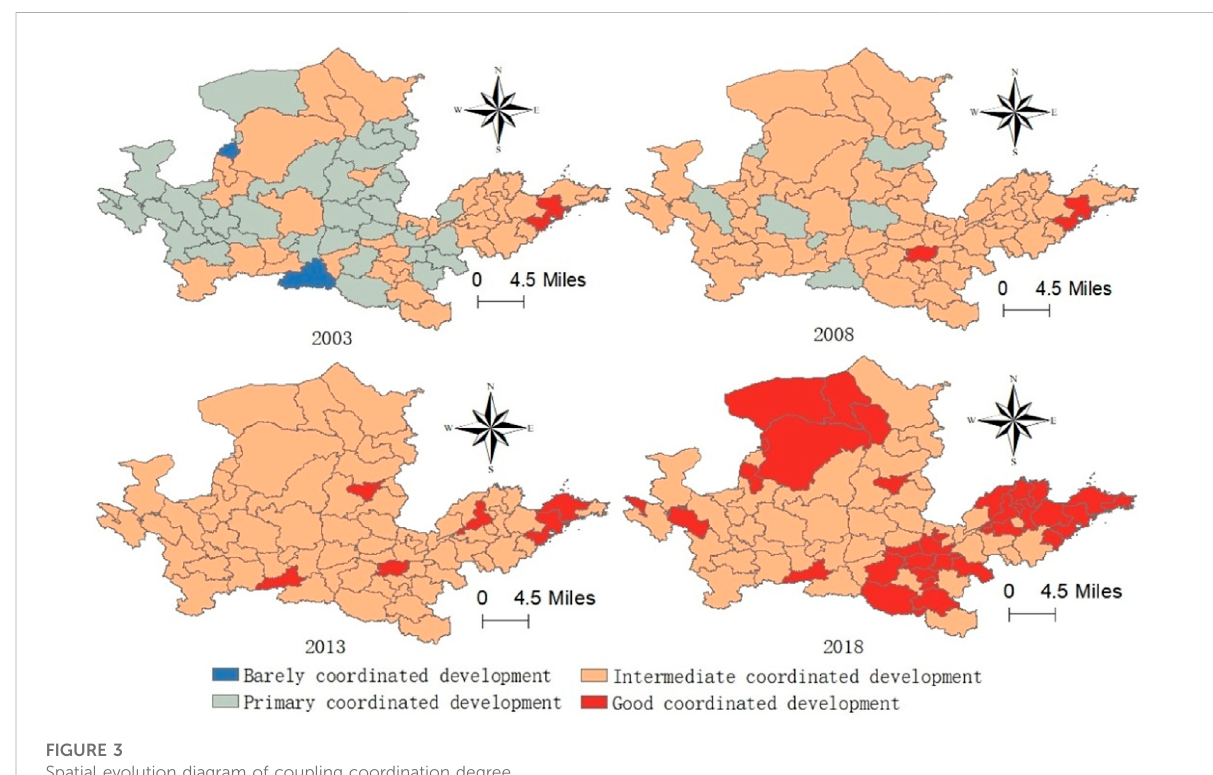
FIGURE 3 Spatial evolution diagram of coupling coordination